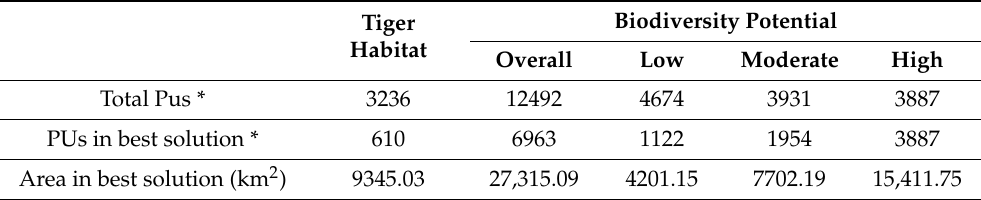
Table 4. Planning units selected for prioritization for each conservation